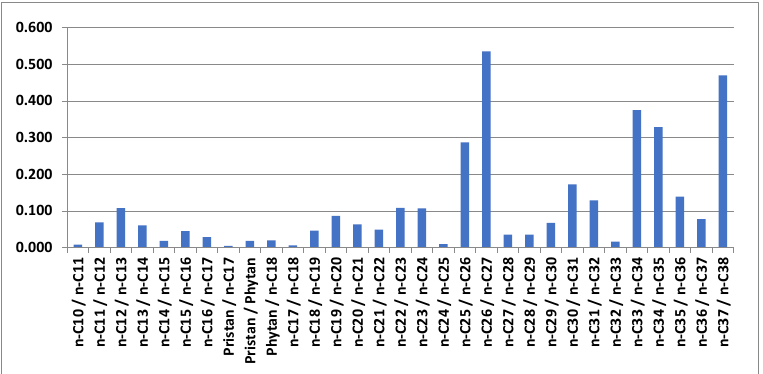
Figure 9. The means of the difference modulus of geochemical characteristics of oil (untreated and treated with the electromagnetic field) as per gas chromatography data.